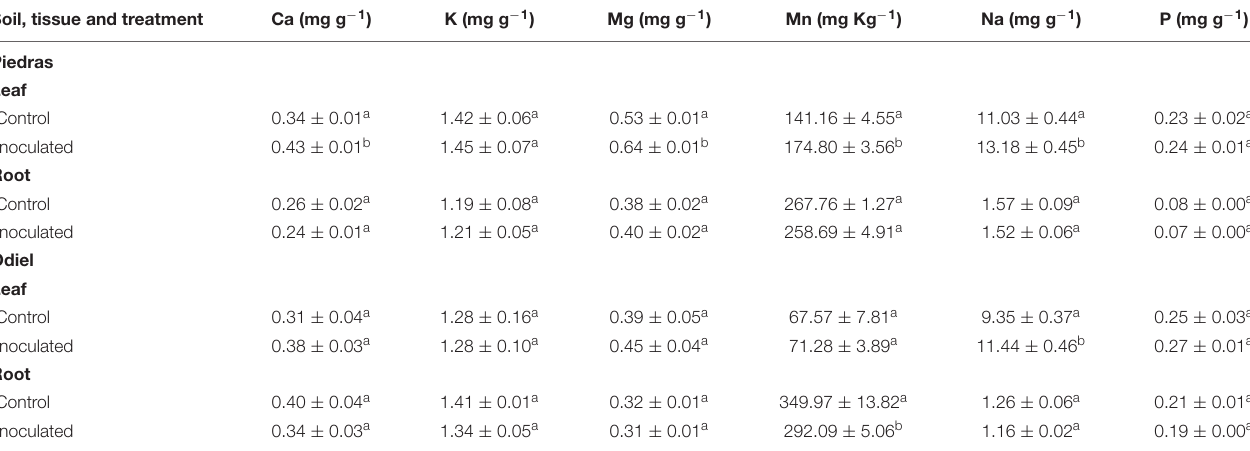
Values are means ± SE. n = 3 and different letters indicate means that are significantly different from each other (p < 0.05).